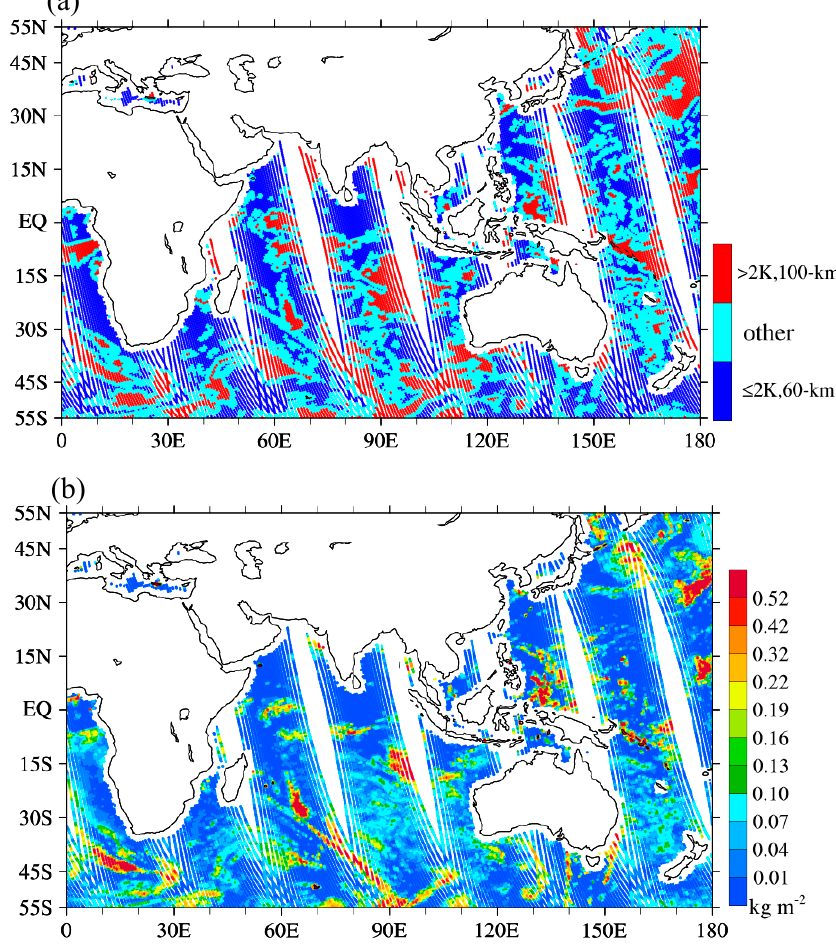
Figure 11. ( a ) AMSU-A data points satisfying ξ O − B ≤ 2 K within a 60-km radial distance (blue, 41.8%) and those satisfying ξ O − B > 2K within a 100-km radial distance (red, 17.2%), as well as the remaining points (cyan, 41.0%). ( b ) AMSU-A liquid water path over oceans in the Eastern Hemisphere on 15 July 2014.